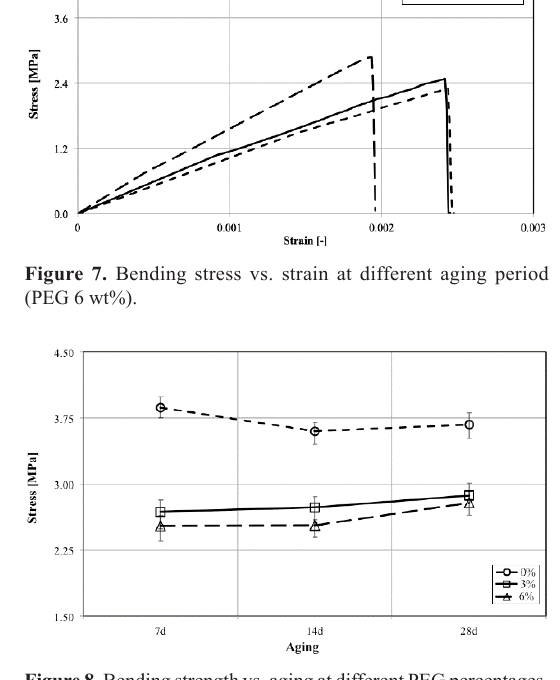
Figure 8. Bending strength vs. aging at different PEG